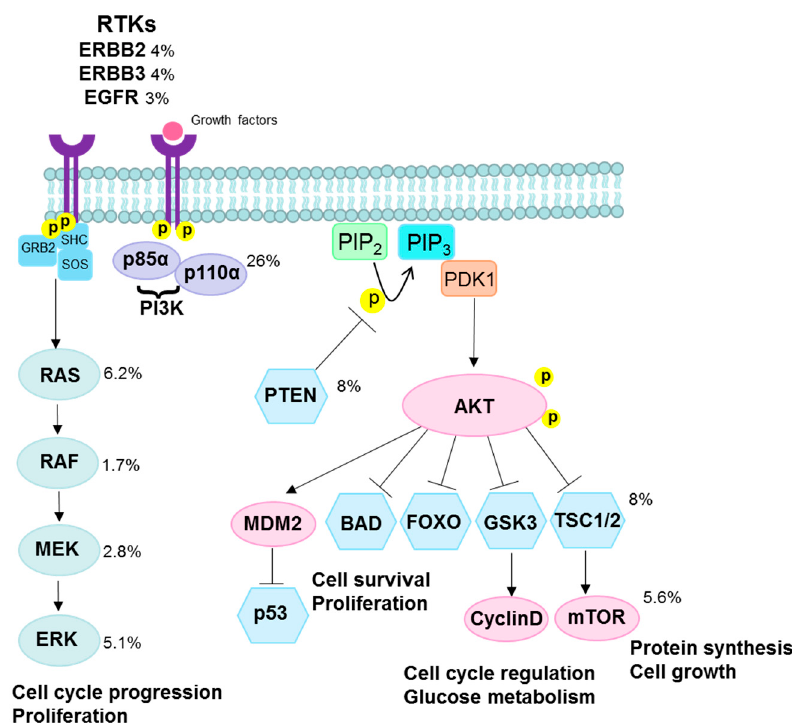
Figure 4. PI3K/AKT and RAS/EGFR/ERK pathways. Class IA PI3K are heterodimers consisting of a p85 α regulatory subunit and a p110 α catalytic subunit (encoded by PIK3CA). The p85 α regulatory subunit normally stabilizes p110 α and inhibits its catalytic activity. Activation of the PI3K pathway via ligand binding to transmembrane RTKs such as EGFR, ERBB2, and ERBB3, results in phosphorylation of p85 α and activation of the p110 α catalytic subunit. Once activated, PI3K phosphorylates PIP 2 at the plasma membrane to produce the lipid second messenger, PIP 3 . This step is inhibited by PTEN, which dephosphorylates PIP 3 to PIP 2 . PIP 3 binds to PDK1 which phosphorylates and activates AKT. Activated AKT phosphorylates TSC1/2, leading to mTOR activation and increased protein synthesis and cell growth. AKT increases cell proliferation by phosphorylating GSK3 which normally regulates the degradation of cyclin D. In addition, activation of AKT promotes cell survival by inhibiting proapoptotic factors such as BAD and FOXO transcription factors, and by phosphorylating MDM2 which antagonizes p53-mediated apoptosis. Other PI3K activation pathways depend on adaptor proteins such as GRB2, which binds to and activates SOS, stimulating RAS and independent activation of p110 α . A Ras-binding domain in p110 α also mediates activation by RAS. RAS-mediated recruitment to the plasma membrane activates RAF, which in turn activates MEK and ERK, respectively. ERK phosphorylates several proteins that control cell proliferation and cell cycle progression. Somatic mutation frequencies in cervical squamous cell carcinomas are shown next to each gene [18]. Abbreviations: RTKs, receptor tyrosine kinases; ERBB2, erb-b2 receptor tyrosine kinase 2; ERBB3, erb-b2 receptor tyrosine kinase 3; EGFR, epidermal growth factor receptor; PI3K, phosphatidylinositol 3-kinases; AKT, protein kinase B; mTOR, mammalian target of rapamycin; PTEN, phosphatase and tensin homolog; PIK3CA, phosphatidylinositol 3-kinase catalytic subunit alpha; PDK1, phosphoinositide-dependent kinase; PIP 2 , phosphatidylinositol 4,5-bisphosphate; PIP 3, phosphatidylinositol 3,4,5-trisphosphate; TSCL1/2, T-cell leukemia 1 and 2; GSK, glycogen synthase kinase; BAD, Bcl-2-associated death promoter; FOXO, forkhead box, O subclass; MDM2, mouse double minute 2 homolog; SHC, Src homology 2 domain-containing; GRB2, growth factor receptor-bound protein 2; SOS, son of sevenless; RAS, retrovirus-associated DNA sequences; RAF, rapidly accelerated fibrosarcoma; MEK, mitogen-activated protein kinase; ERK, extracellular signal–regulated kinases.